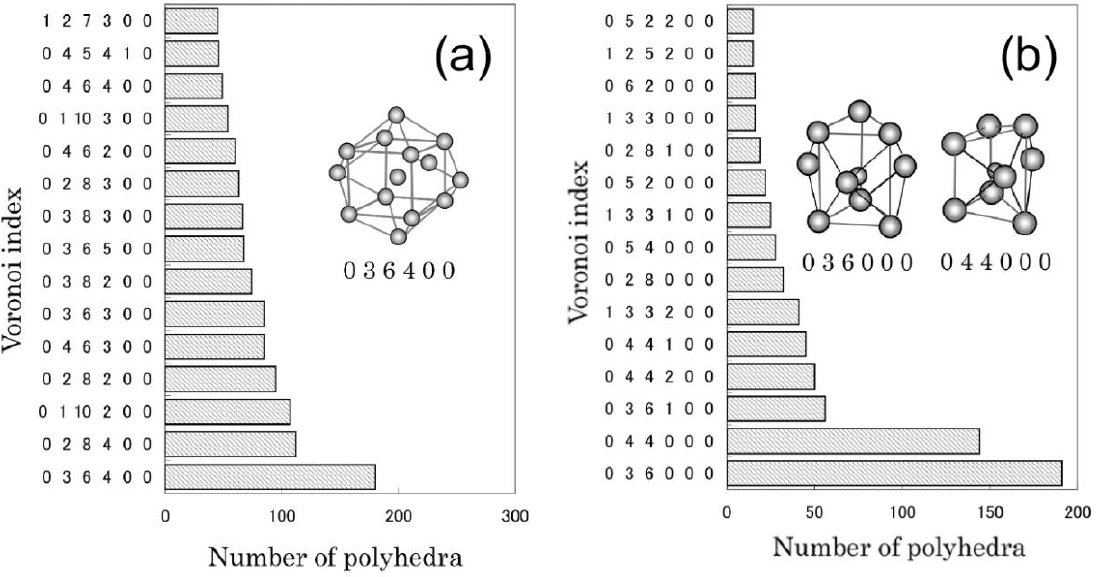
Figure 2. Voronoi polyhedral analyses for the reverse Monte Carlo (RMC) structure model which reproduces the interference function i(Q) obtained from Fe polyhedra with central ( a ) Fe and ( b ) B atoms found in the final structural model are